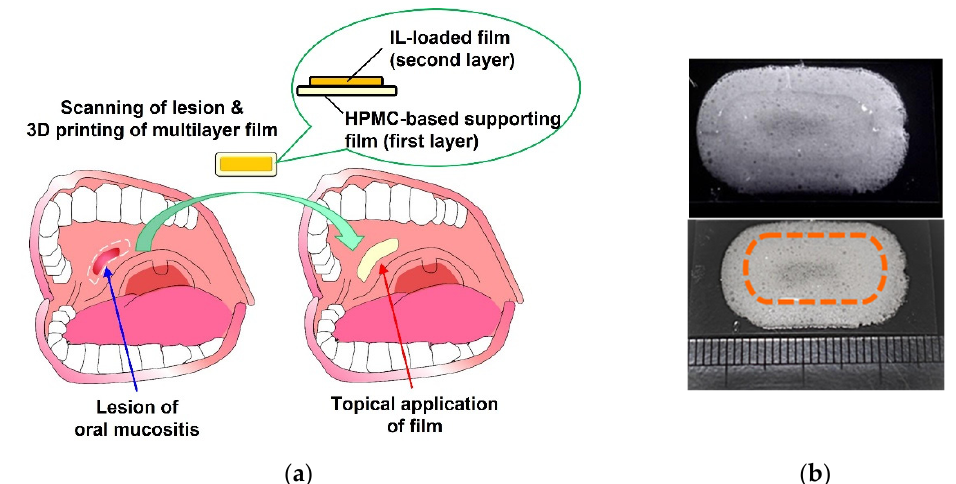
Figure 7. ( a ) Scheme describing the application of a 3D printed film to an oral mucositis site. ( b ) Appearance of a multilayer film comprising an IL-loaded layer and a HPMC-based supporting layer. Information on the printer ink formulation (formulation B) and the HPMC-based ink is shown in Table 1 and in Section 2.